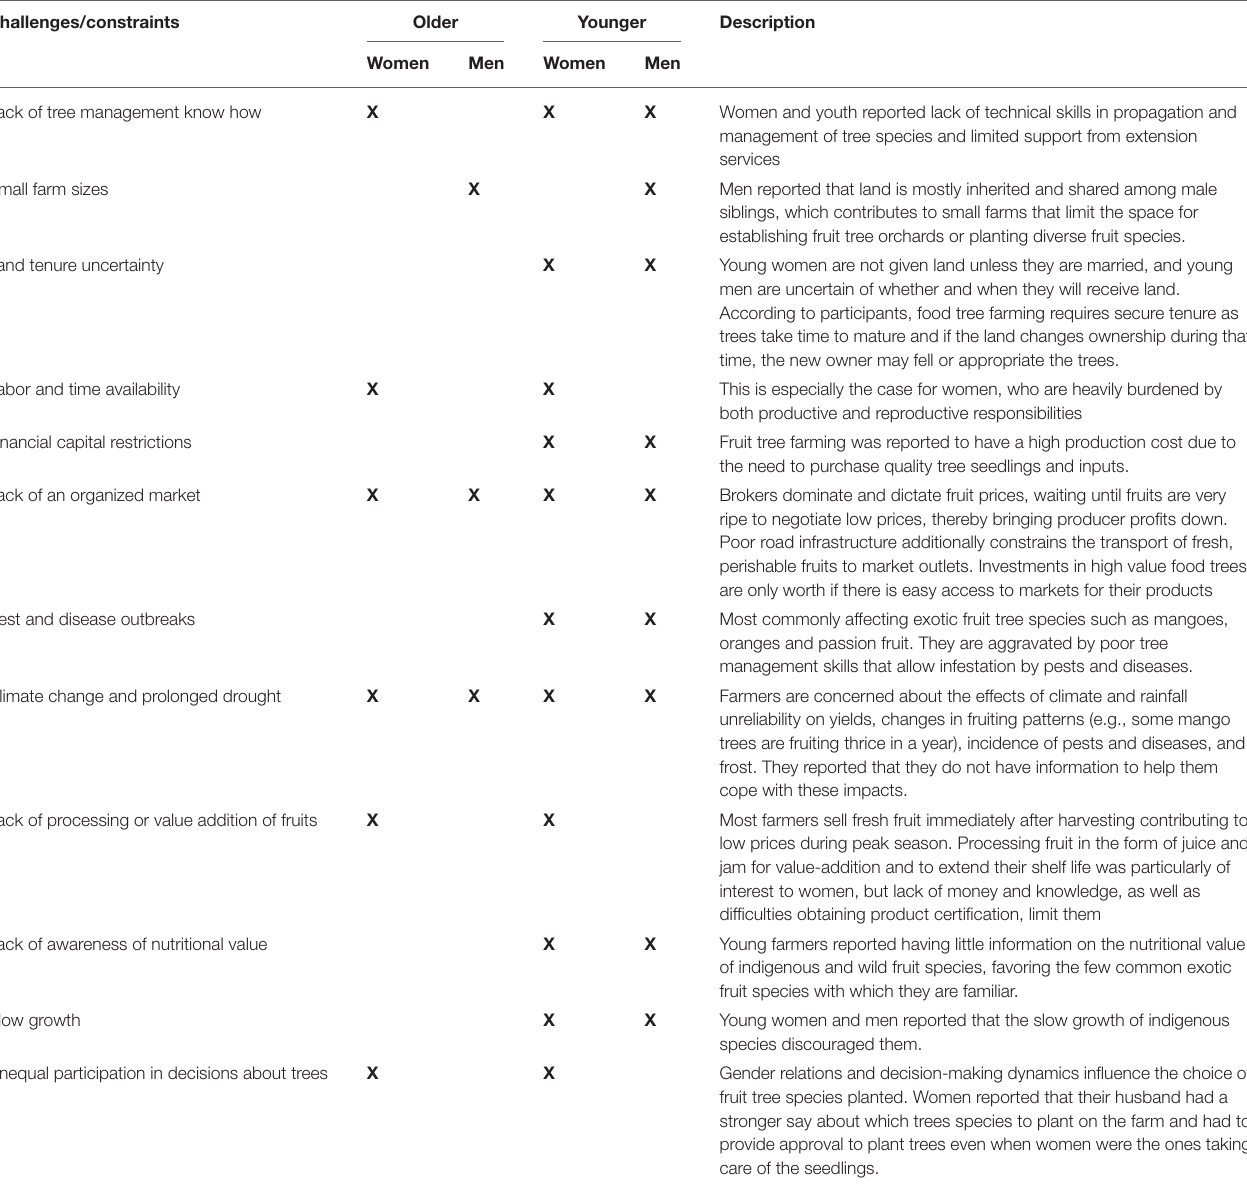
TABLE 6 | Most mentioned constraints and challenges of growing food tree species according to different gender and age groups in both Kenya and